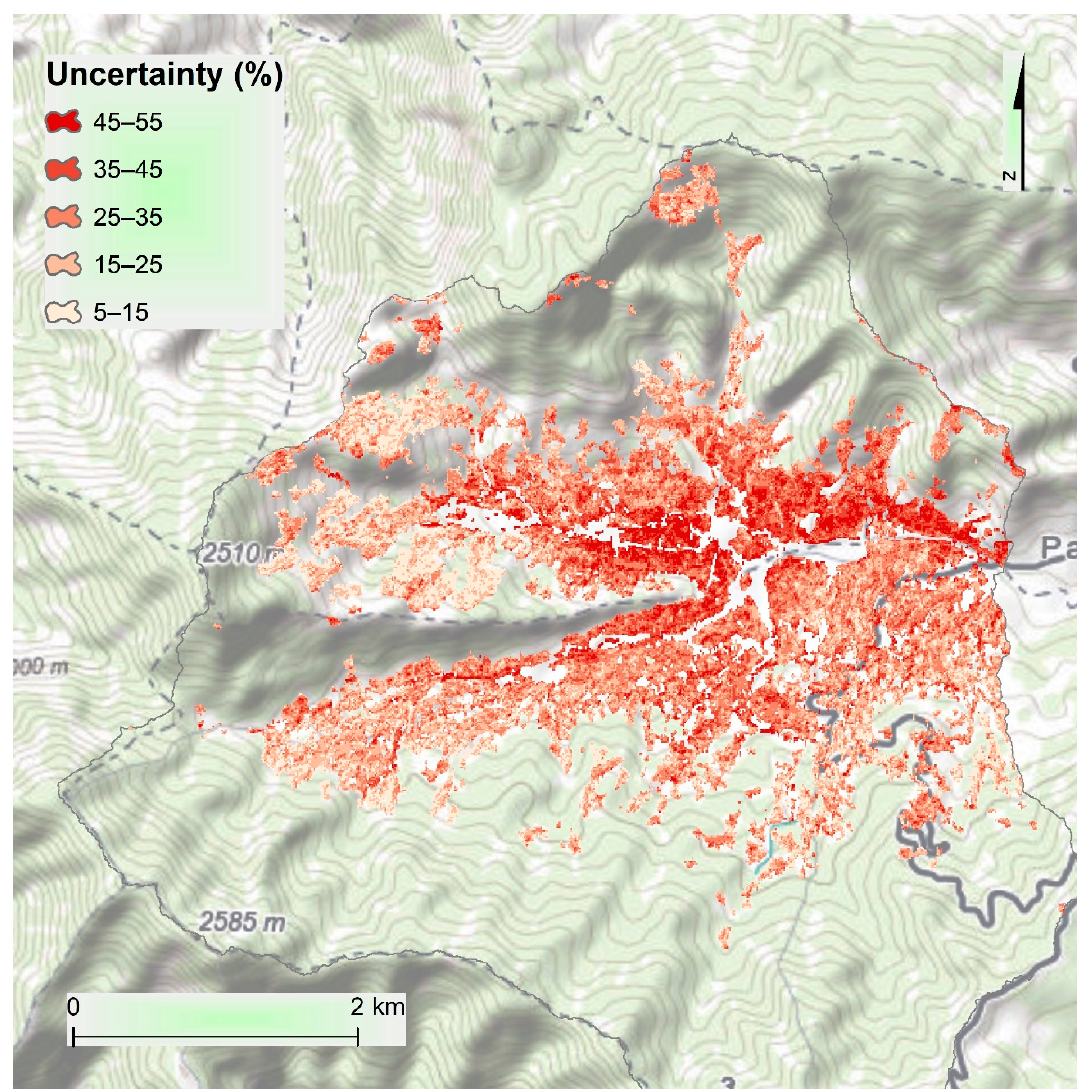
Figure 6. Prediction uncertainty of SOC using the best of nine